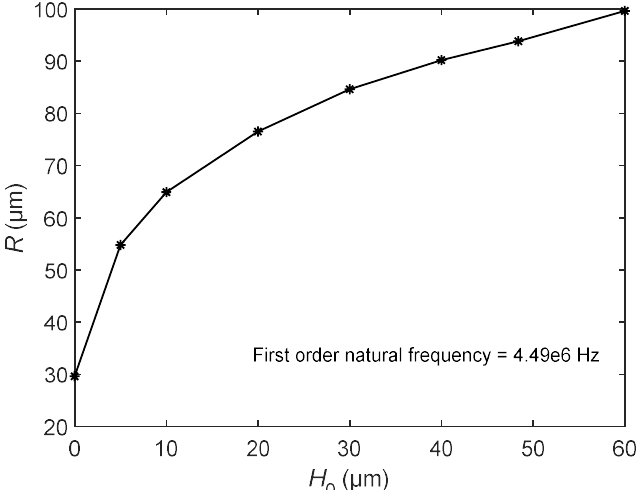
Figure 13. The relationship between radius R and height H 0 when the first natural frequency is constant.